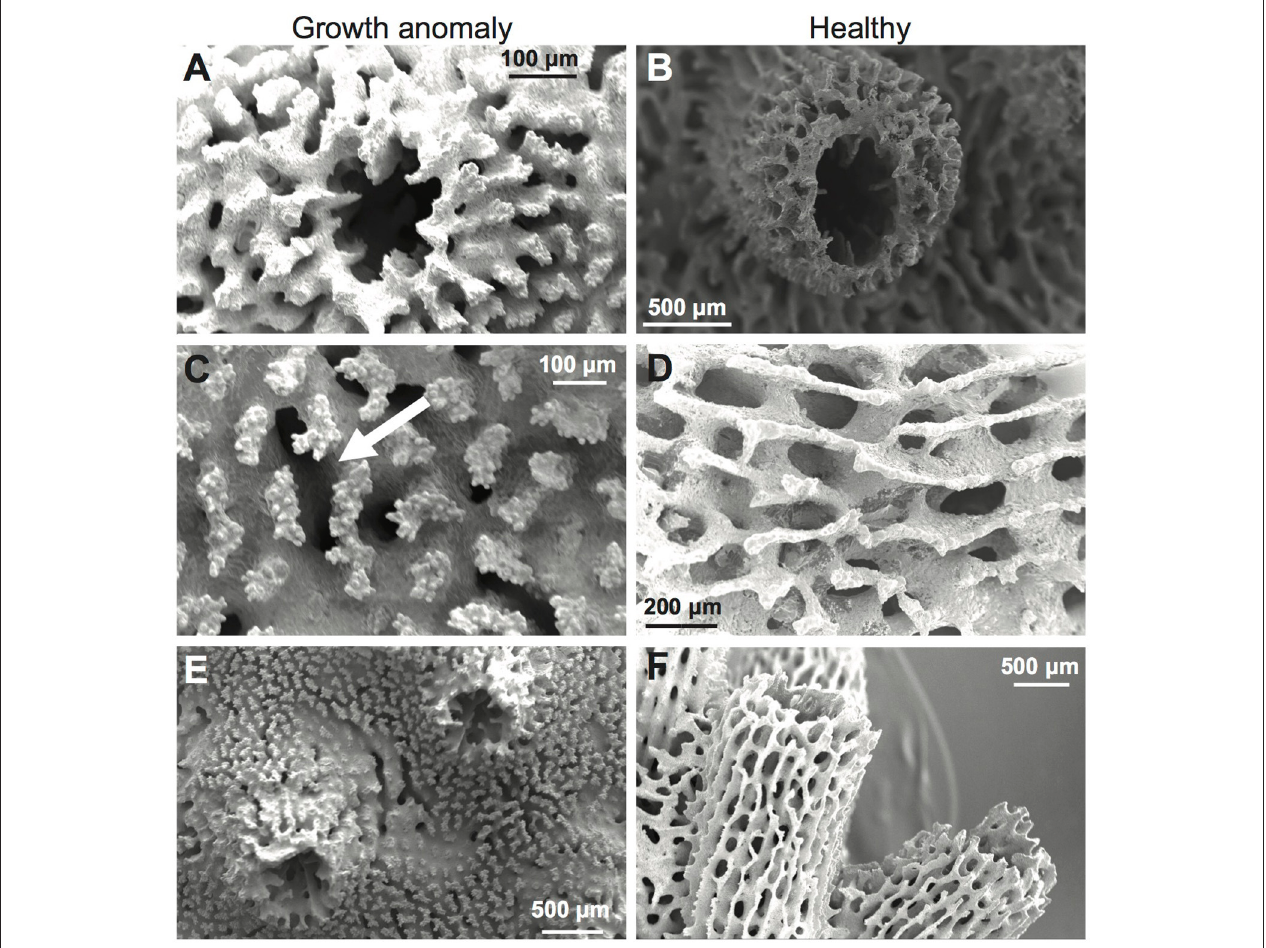
FIGURE 5 | Scanning electron micrographs (SEMs) of A. muricata skeletons with (A,C) and without (B,D) growth anomalies. (A,B) Septa, corallite walls, and coenosteal networks; note raised wall in normal skeleton. (C,D) Coenosteum; in GA, note thickened coenosteum with elaborate thickened spinules (arrow), compared to linear costate ridges in healthy skeleton. (E,F) Overall coenosteum and corallite